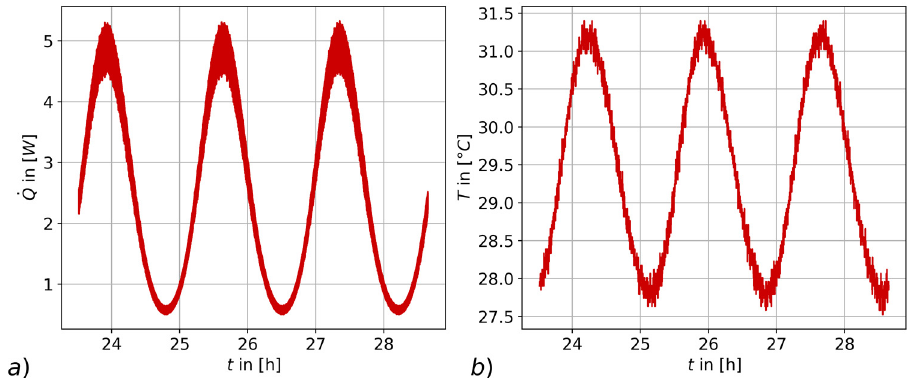
Figure 2. Section of real measured data for 160 µ Hz data point. ( a ) Dissipated heat by irreversible heat; ( b ) measured thermal response on the centre of the cell’s surface caused by the corresponding heating in ( a ).